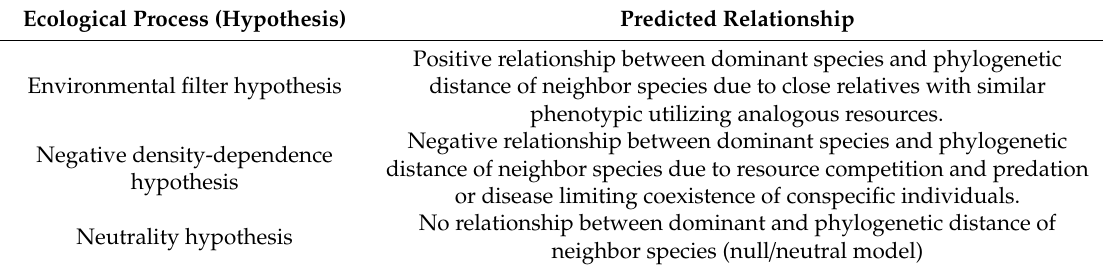
Table 1. Predicted e ff ects of di ff erent ecological processes on community structure of a dominant species relative to the phylogenetic distance of its